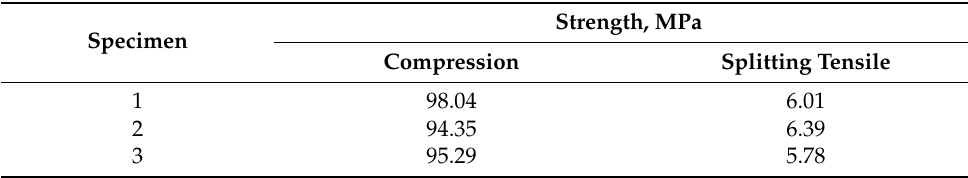
Table 2. Experimental values of SFHSC strength.